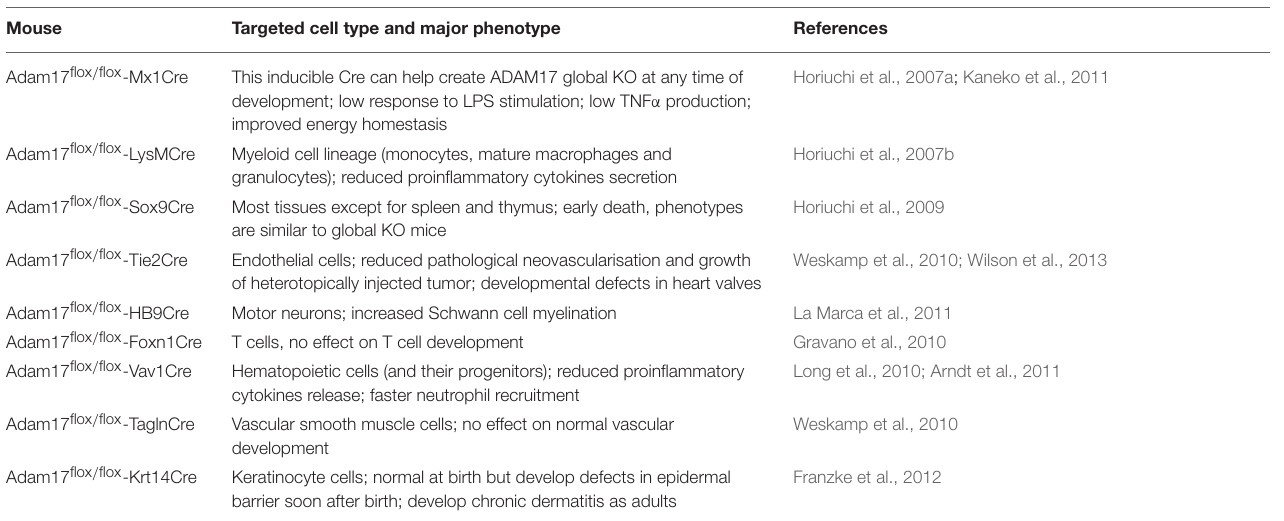
TABLE 1 | Summary of ADAM17 conditional knockout